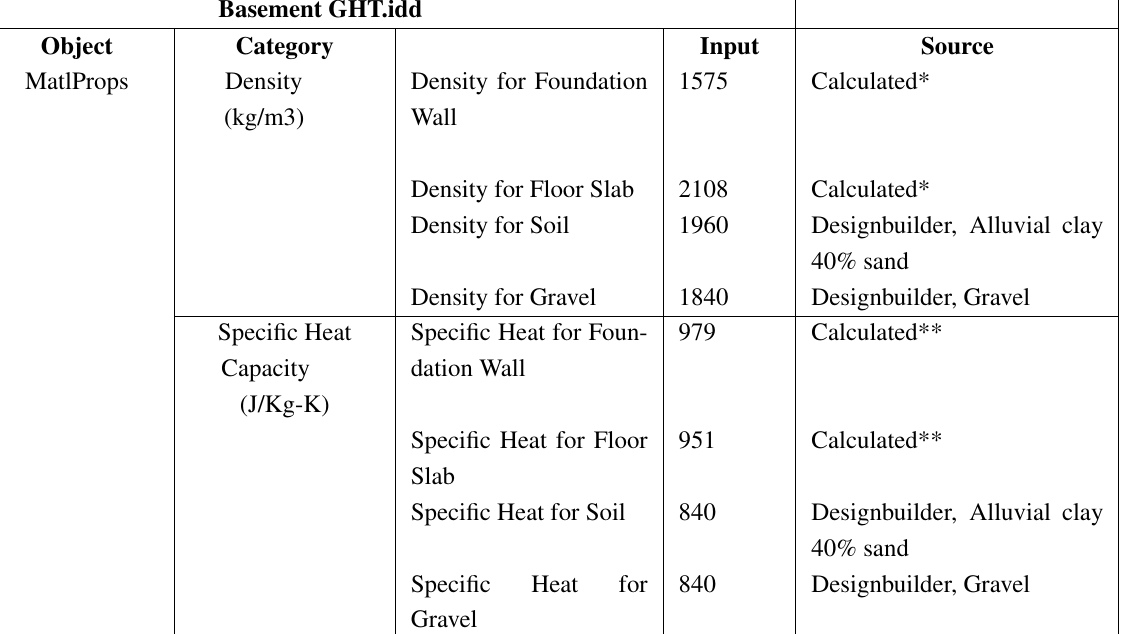
Table 1. Localized inputs for the Basement preprocessor, for the Egyptian local building material